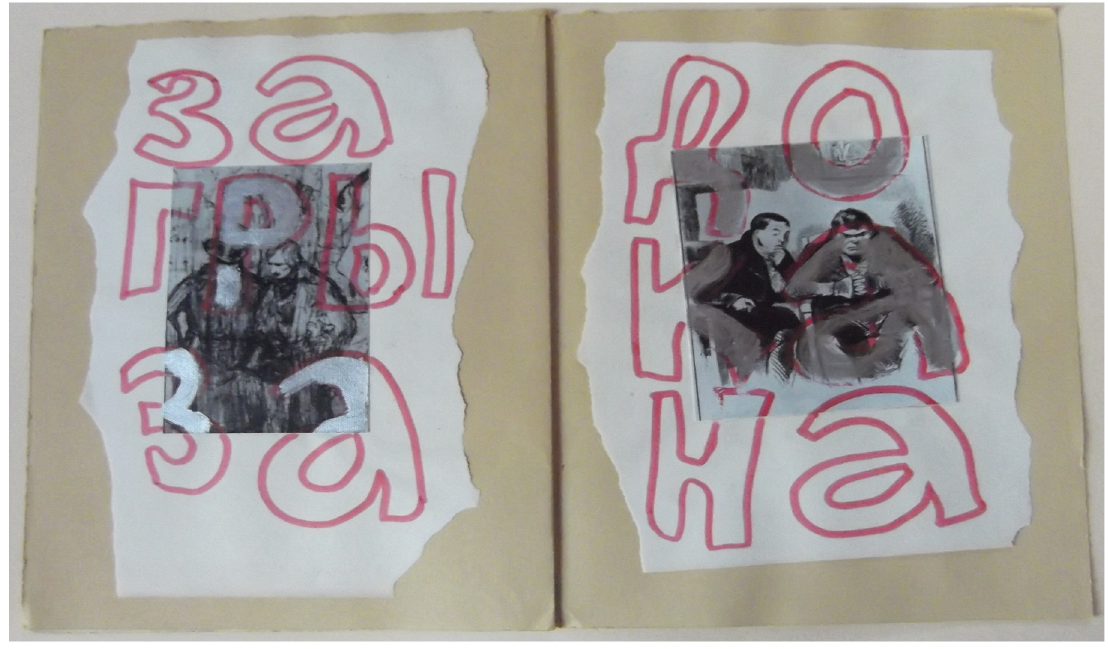
Figure 18. Pages from the third booklet.